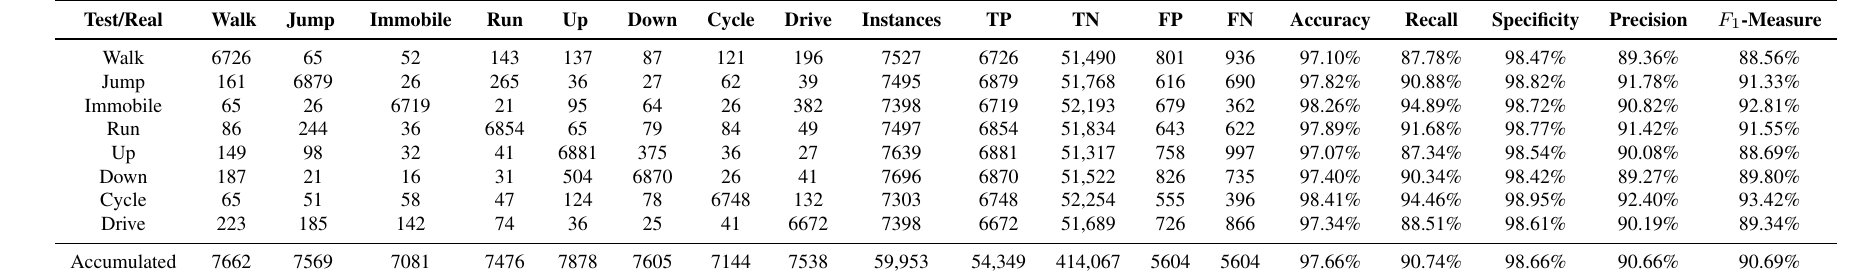
Table B6. Confusion matrix and performance values for the KNN-based classification